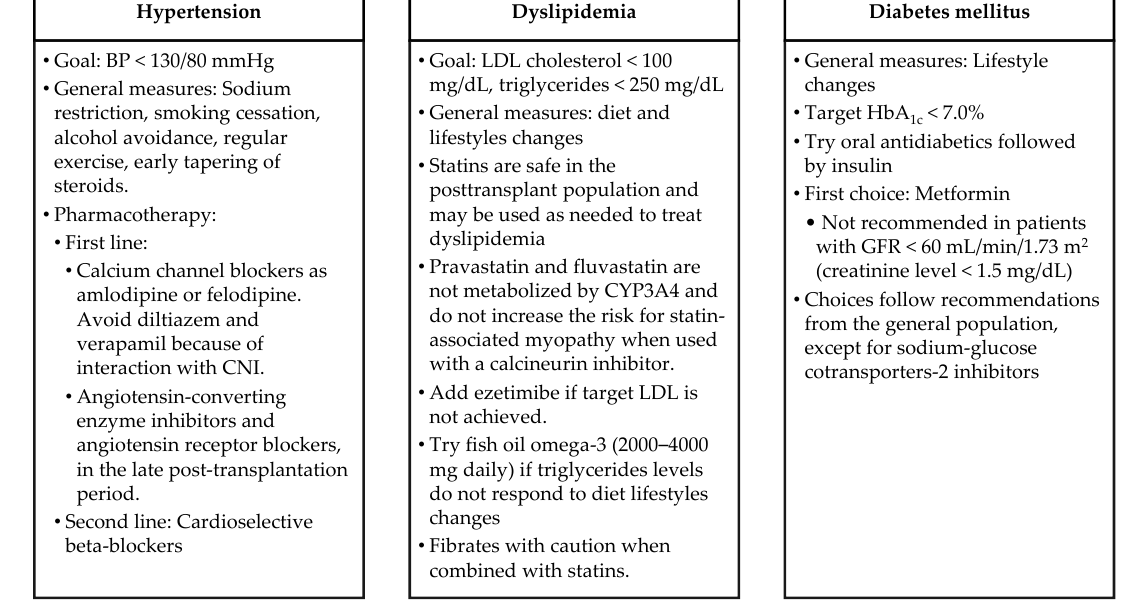
Figure 2. Key points in the management of hypertension, dyslipidemia, and diabetes mellitus in post-liver transplant patients. BP—blood pressure; CNI—calcineurin inhibitors; LDL—low-density lipoprotein; CYP3A4—cytochrome P450 3A4; HbA 1c — hemoglobin A 1c ; GFR—glomerular filtration rate.